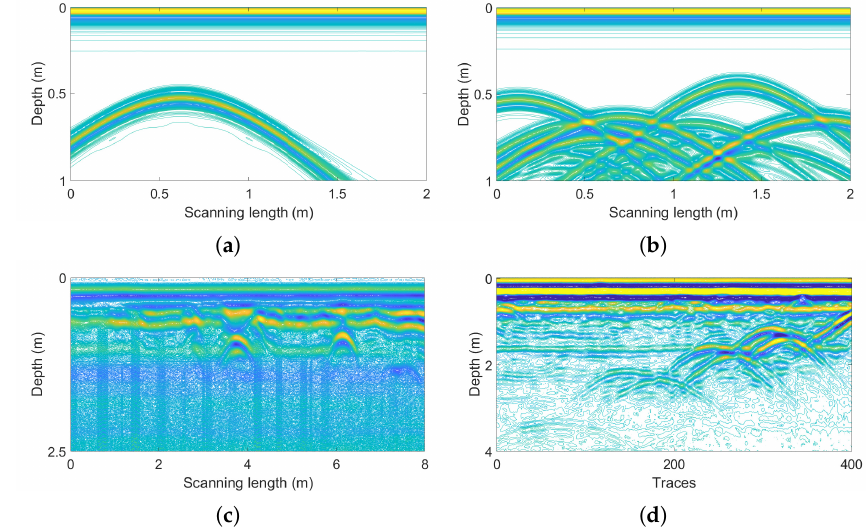
Figure 4. Example data profiles after preprocessing of ( a ) Figure 1c, ( b ) Figure 1d, ( c ) Figure 2a, and ( d ) Figure